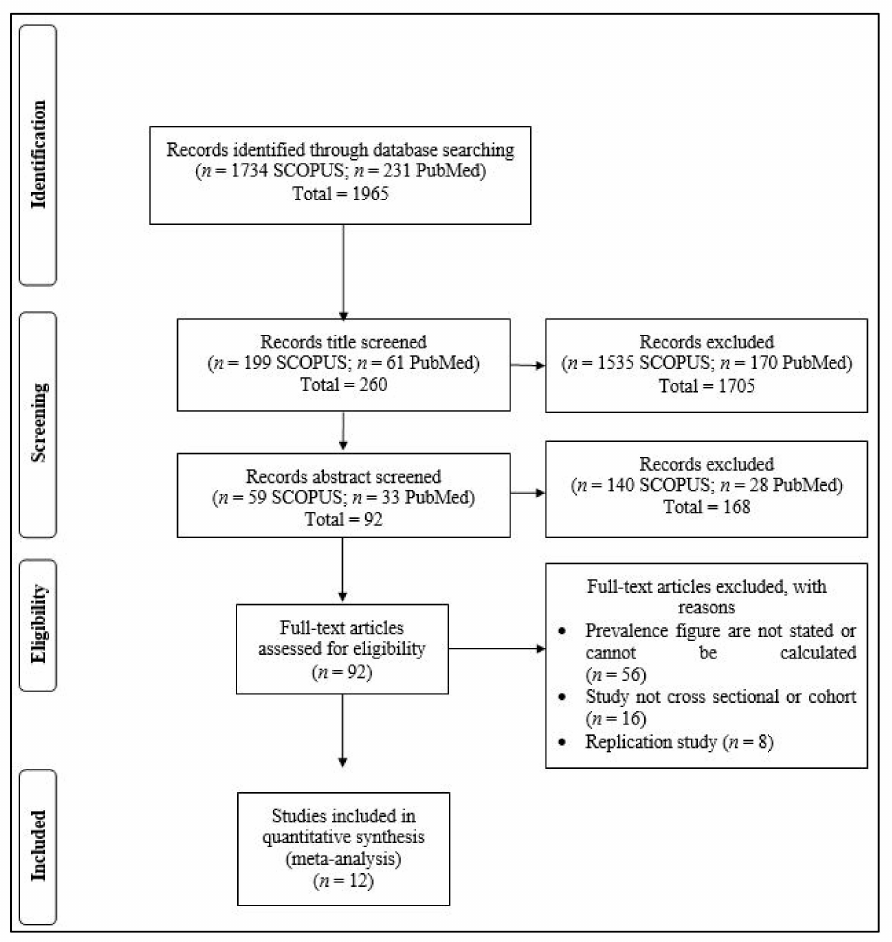
Figure 1. PRISMA flow diagram of systemic literature search from 1 January 2016 to 1 June